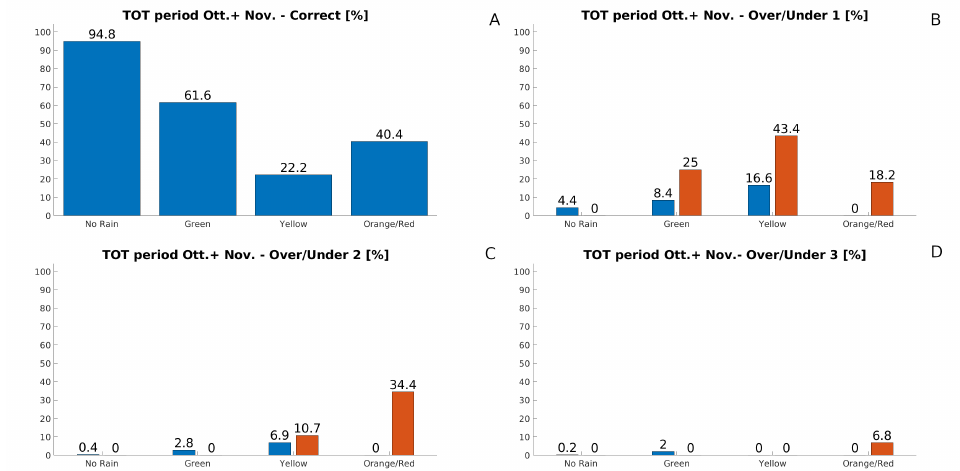
Figure 9. Performance obtained using the complete SWING algorithm. In panels ( B – D ), overestima- tions are represented in blue and underestimations are represented in orange, panel ( A ) represents the correct forecast